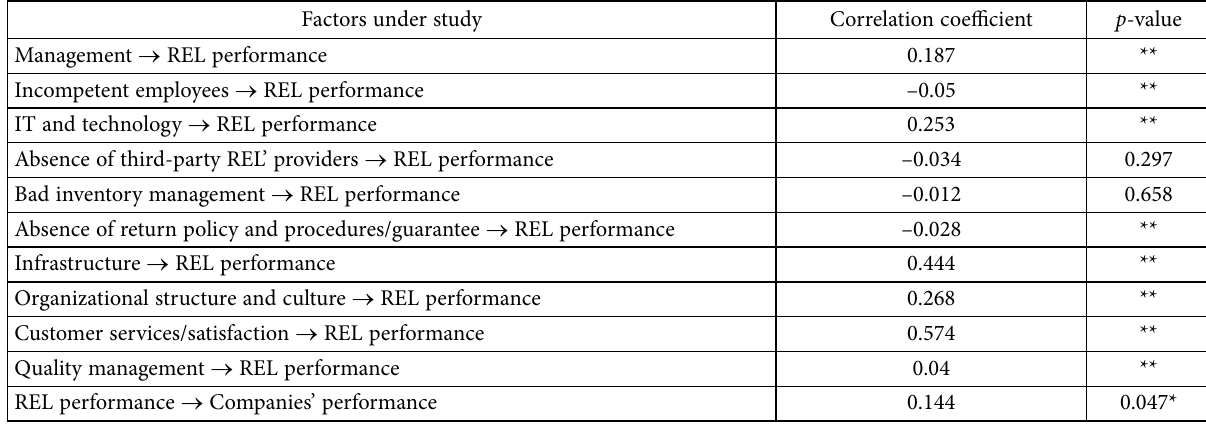
Table 9. Correlation coefficient of factors affecting REL (source: compiled by authors 2020) Factors under